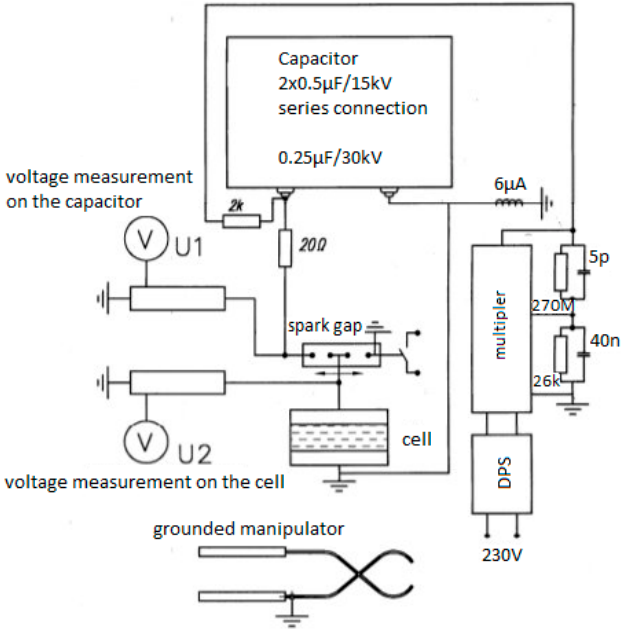
Figure 4. Schematic diagram of an electrical system for generating PEF pulses with an “exponential” shape [32].